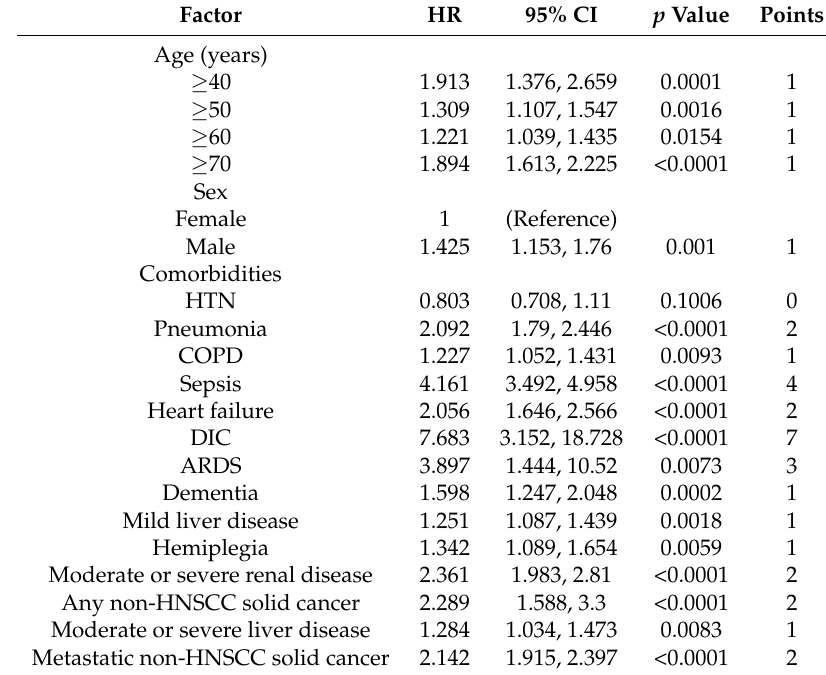
arterial disease: CAD; end stage renal disease: ESRD; Chronic kidney disease: CKD; disseminated intravascular coagulation: DIC; adult respiratory distress syndrome: ARDS; peripheral vascular disease: PVD; peptic